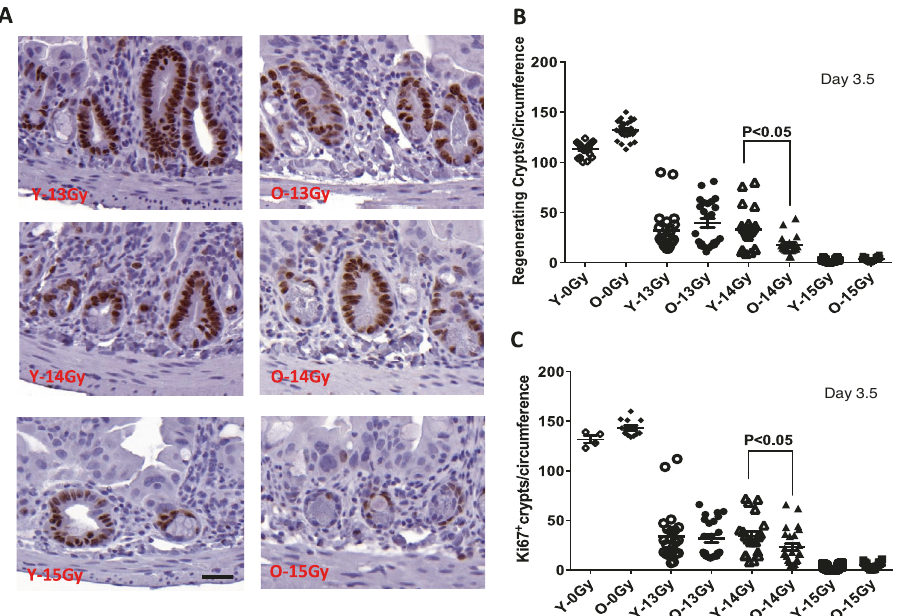
Fig. 2 Regenerating crypts per jejunum circumference at 3.5 days post subtotal RT. The sections of proximal jejunum were obtained from animals sacri fi ced at 3.5 days post-radiation. A Representative images of regenerating crypt 3.5 days post subtotal RT. B Quantitation of regenerating crypt numbers. A regenerating crypt was de fi ned as a crypt containing at least 1 Paneth cell, over 10 non-Paneth cells and 1 lumen; appearing intensely stained body in HE-section. C Quantitation of regenerating crypt number was scored by counting Ki67-positive crypts. Data are presented as means ± SD. N = 3 mice/group, 10 circumferences per mouse. * P < 0.05 Y-14Gy vs O-14 Gy, Student ’ s t -test. Scale bar 20 μ m.